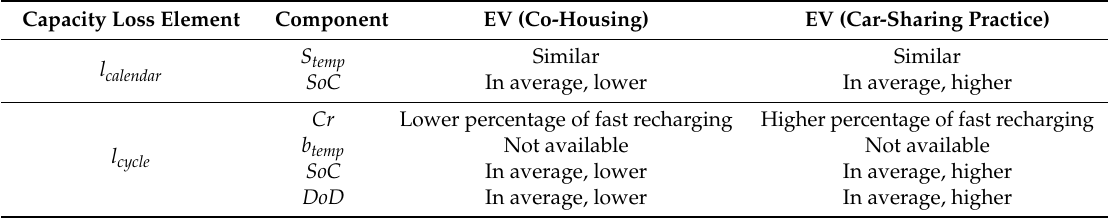
Table 4. Comparison of the EV batteries utilization conditions. N/A: not available; and DoD : depth of